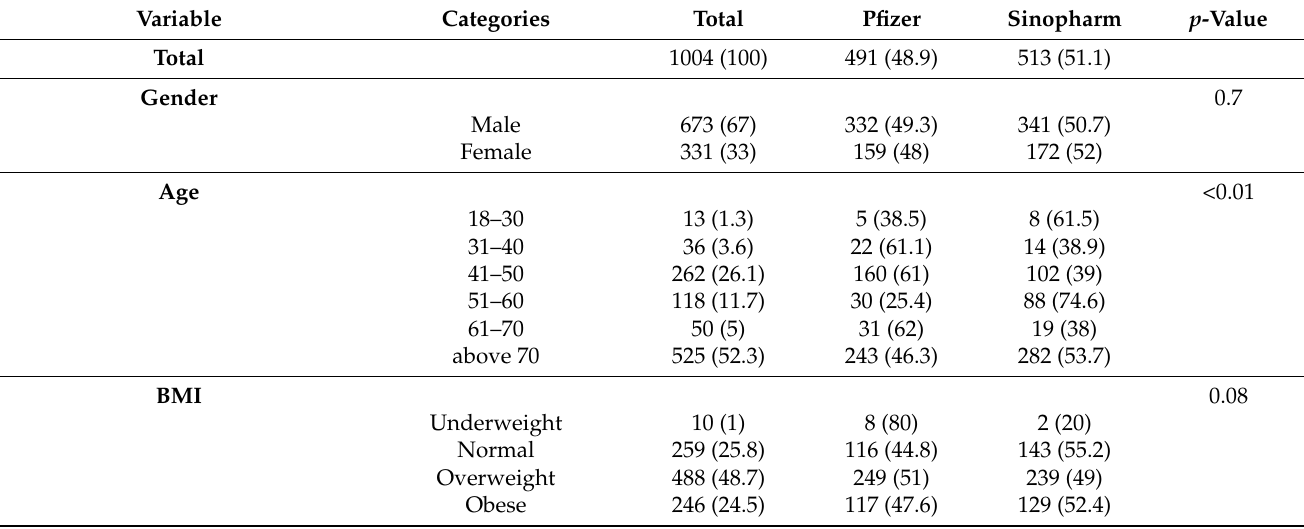
Table 1. Baseline characteristics of the 1004 vaccinated individuals, in terms of the used vaccine.